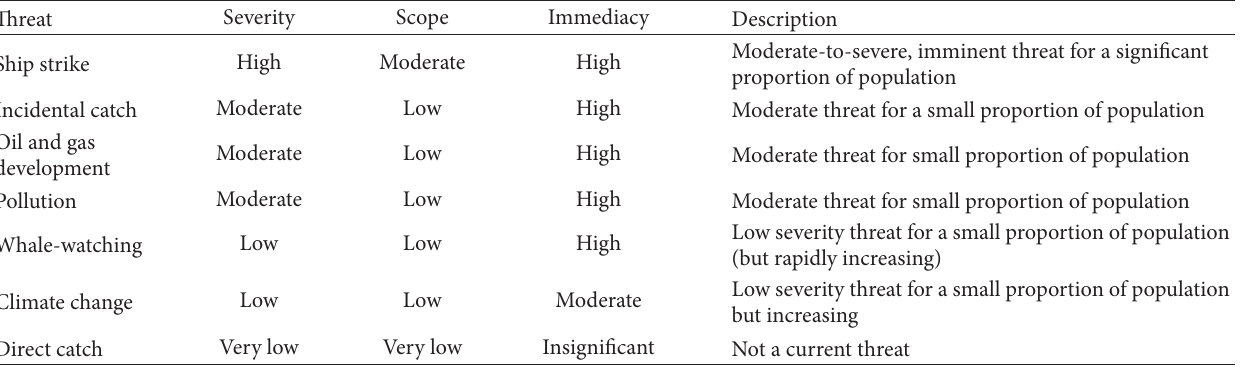
Table 1: Prioritization of threats to Northern Indian Ocean pygmy blue whales in Sri Lankan waters (categories and descriptions based on Regan et al.